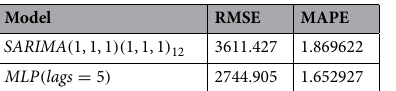
Table 4. Comparing the performances of the SARIMA and MLP models.